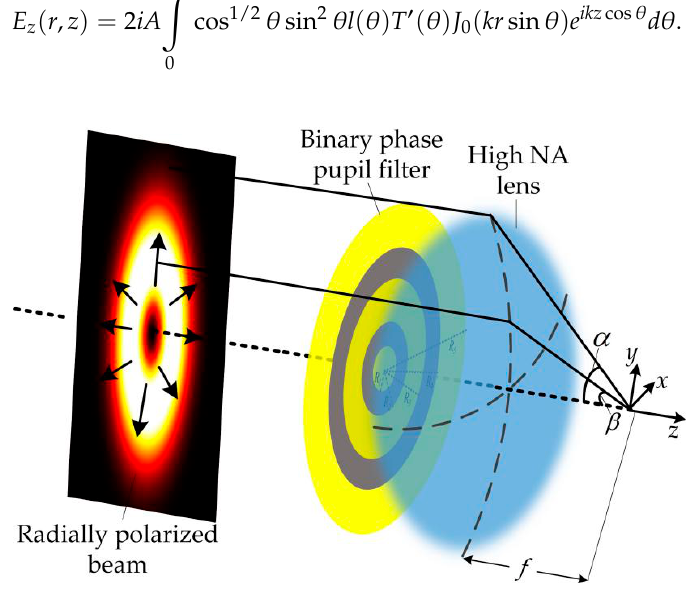
Figure 2. Schematic of focusing of a radially polarized beam with a binary phase pupil filter (BPPF) and high numerical aperture (NA) lens.